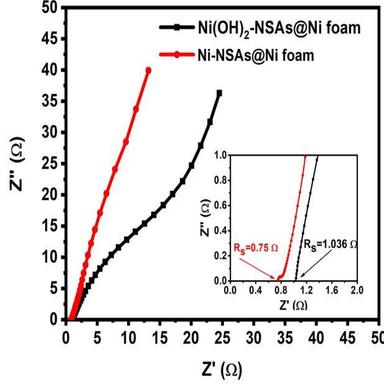
Illustrates Nyquist plot at open circuit potential, the inset shows a zoomedout image of the high frequency region of both Ni(OH)2-NSAs@Ni foam and Ni-NSAs@Ni foam electrodes.